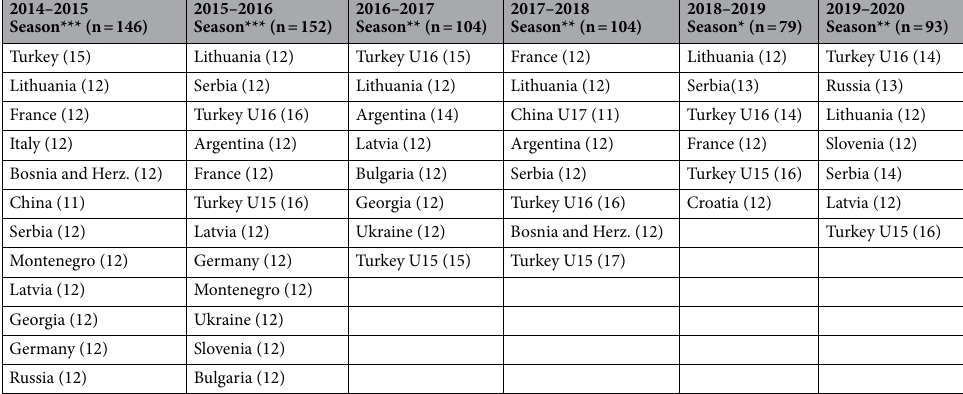
Table 1. TBF International U-16 Men Basketball Tournament results (n = 678). The number of players in the teams was given in brackets. *Each team played five games in the season. **Each team played six games in the season. ***Each team played seven games in the